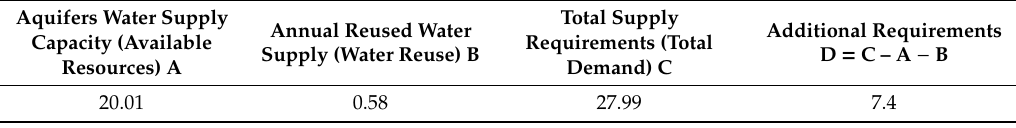
Table 4. Additional supply requirements (hm 3 / year) 2015.